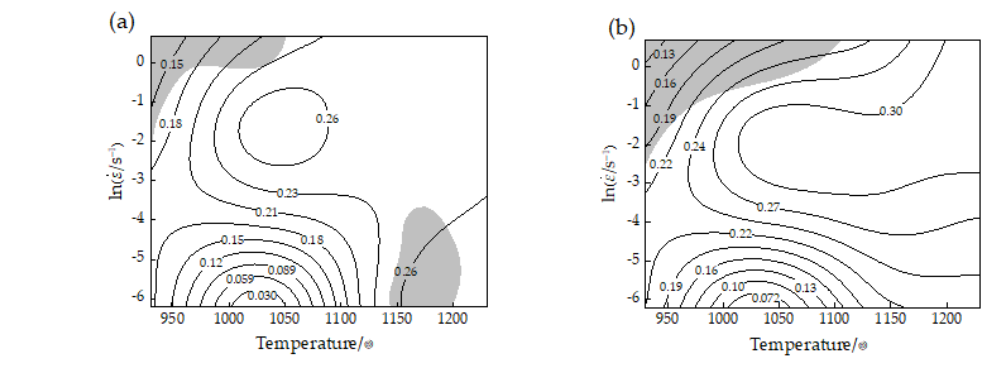
Figure 10. Processing maps for the 20MnCr5(SH) gear steel at strains of ( a ) 0.1; ( b ) 0.2; ( c ) 0.3; ( d ) 0.4; ( e ) 0.5; ( f ) 0.6. To summarize, when processing high quality 20MnCr5(SH) gear steel by hot plastic- ity, it should refer to the processing maps, avoid the plastic instability zone and try to select the area with high processing efficiency zone, so as to obtain good forging structure and improve the comprehensive mechanical properties and quality of the product. 6. Conclusions (1) The higher the hot deformation temperature of 20MnCr5(SH) gear steel is, the smaller the flow stress is, and vice versa; the lower the strain rate is, the smaller the flow stress is, and vice versa. The observation of metallographic structure shows that dynamic recrystallization occurs during hot deformation of 20MnCr5(SH) gear steel. The austenite grains are filled with martensite lath bundles. (2) According to the true stress-strain curve, the parameters of the constitutive equation are obtained by linear fitting method, and the 20MnCr5(SH) constitutive equation is obtained. The thermal deformation activation energy Q act of 20MnCr5(SH) is 356.412